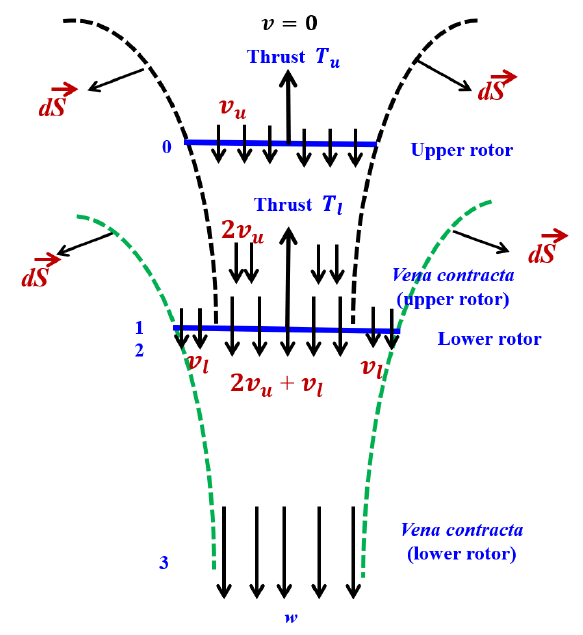
Figure 1. Flow model of coaxial rotor system with lower rotor operating in the vena contracta of the upper rotor (Leishman & Syal,